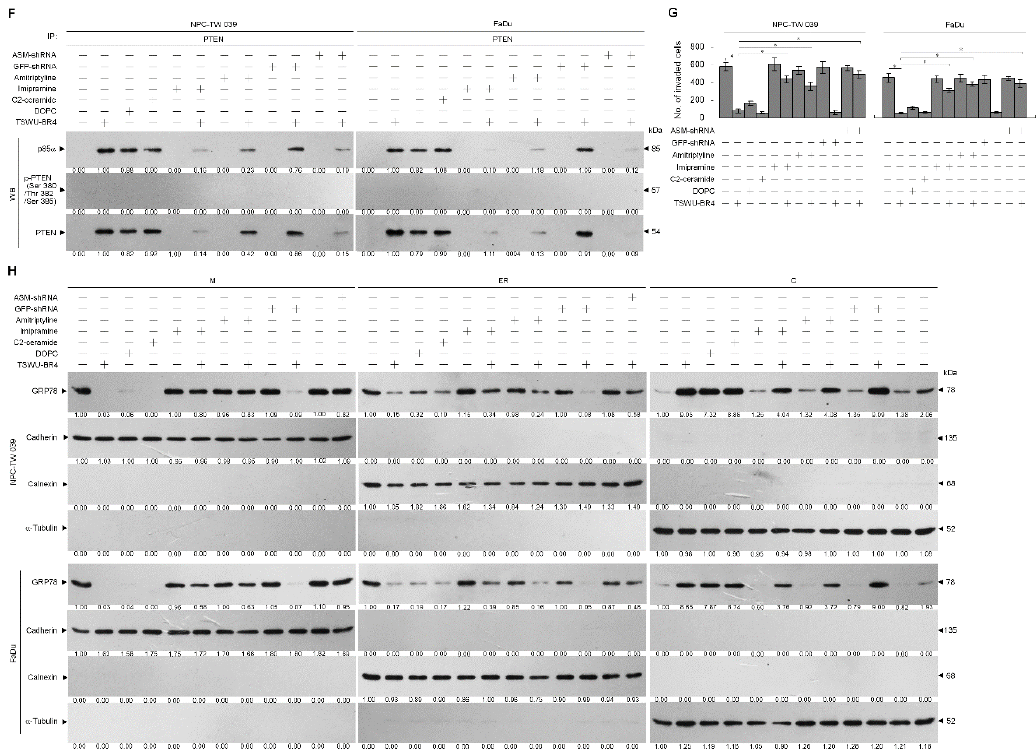
Figure 5. Lipid raft membrane-associated ASM activity is involved in TSWU-BR4-induced inhibition of GRP78-modulated oxidative stress balance and cell invasion. ( A ) Cells were treated with vehicle ( − ) or TSWU-BR4 (300 nM) for 36 h. DRM and DS fractions were prepared by flotation on a sucrose density gradient. The levels of the indicated proteins in the lysates of vehicle- or TSWU-BR4-treated DRM and DS fractions were determined by Western blot analysis using specific antibodies. At 12 h after transfection with an empty vector, GFP shRNA or ASM shRNA cells were treated with either vehicle ( − ), TSWU-BR4 (300 nM), DOPC (15 nmole), C2-ceramide (6 µ M), imipramine (5 µ M), TSWU-BR4 (300 nM) plus imipramine (5 µ M), amitriptyline (8 µ M), or TSWU-BR4 (300 nM) plus amitriptyline (8 µ M) for 36 h. ( B ) The levels of the indicated proteins in the cell lysates were determined by Western blot analysis with specific antibodies. β -Actin was used as an internal control for sample loading. ( C ) ASM activities were determined by Acidic Sphingomyelinase Assay Kit. Cell viability was determined by the flow cytometric analysis of PI uptake. ( D ) The lipids were extracted from the DRM or ER fractions, and cholesterol, sphingomyelin, and ceramide were quantitated by Amplex Red Cholesterol Assay Kit and thin-layer chromatography, respectively. Ceramide concentrations were normalized to phospholipid phosphate. ( E , F ) The antibodies used for co-immunoprecipitation are indicated at the top of the figure. The proteins in the immunoprecipitated complexes from the DRM were analyzed by Western blot using specific antibodies. ( G ) The invaded cell numbers were assessed by the Matrigel invasion assays. ( H ) The levels of the indicated protein in the extracts of M, ER, and C fractions prepared from the cells treated as described above and determined by Western blot analysis using specific antibodies. The values are presented as the S.E.M. of three independent experiments. * p < 0.05: significantly di ff erent from empty vector-transfected TSWU-BR4-treated cells.